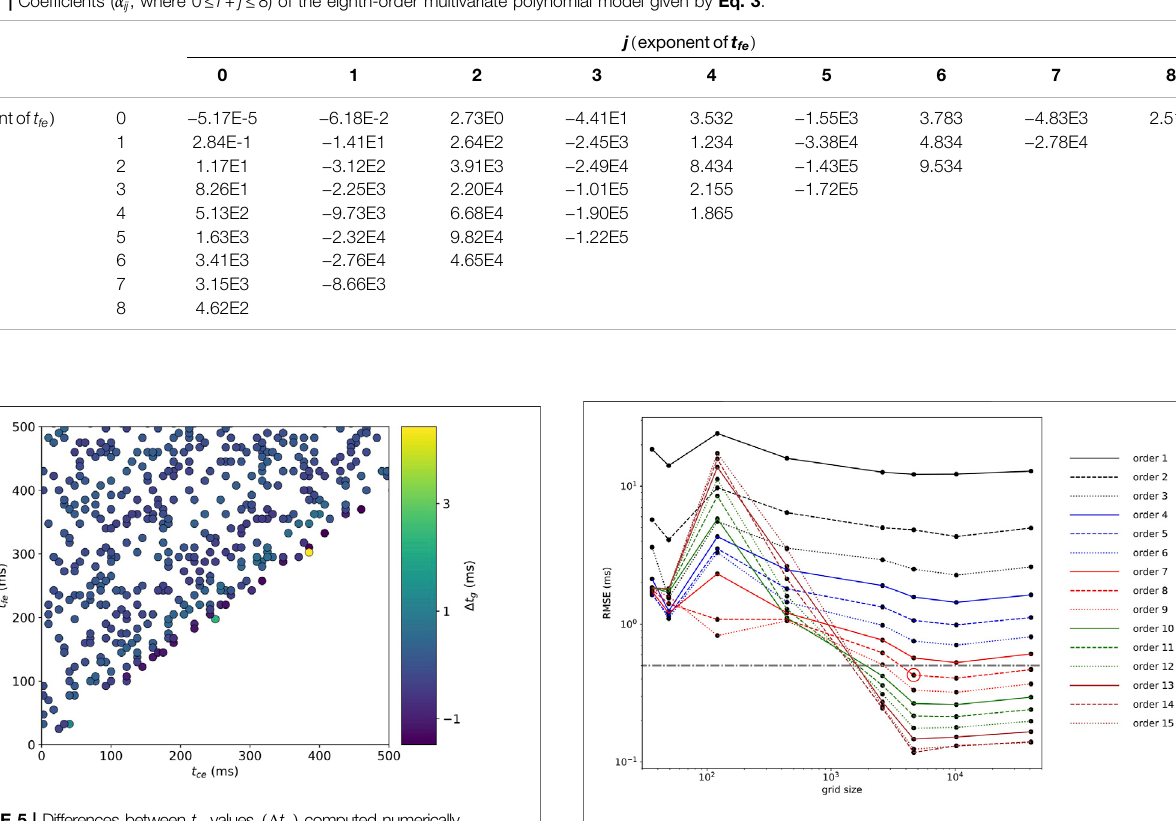
FIGURE 7 | Root-mean-square error as a function of grid size ranging from 36 to 40,804 total points and for each polynomial regression (1st to 15th order). The red circle denotes RMSE corresponding to a polynomial (eighth order) chosen in Section 3.2 (0.43 ms), and the gray line depicts an RMSE threshold of 0.5 ms.